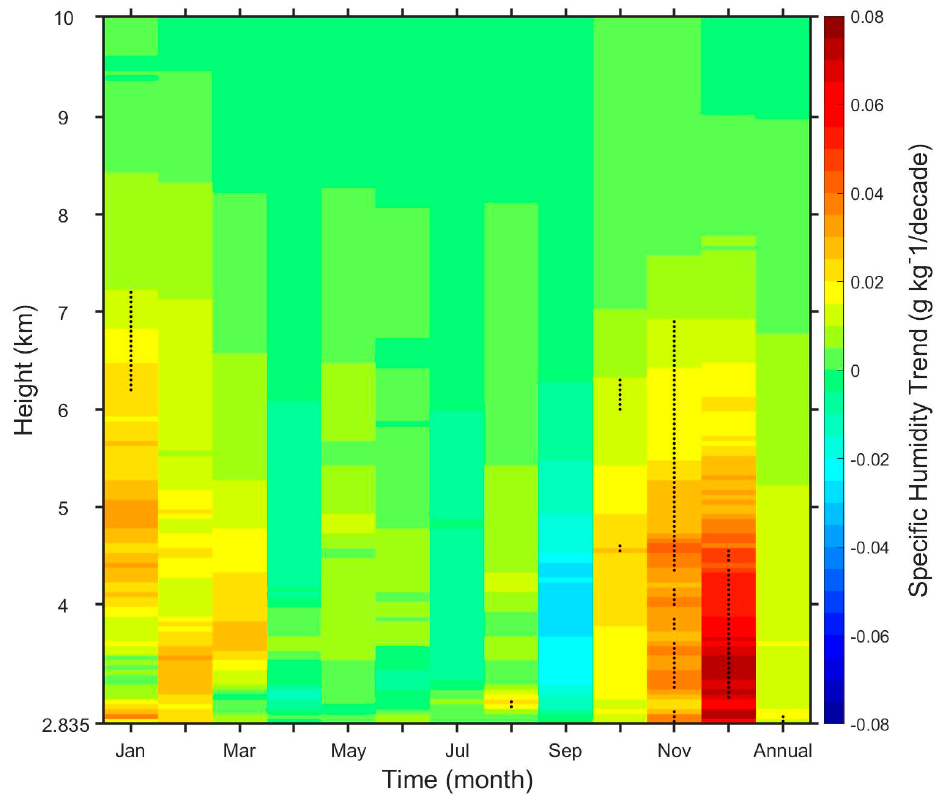
Figure 11. Same as Figure 4, but for specific humidity.